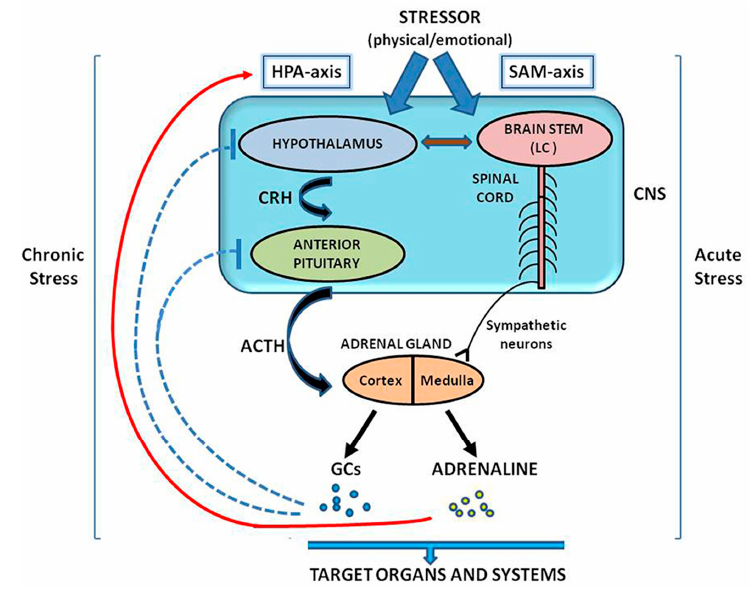
Figure 1. Schematic representation of the actions of HPA and SAM axes in the regulation of stress response. CRH is the key neuroendocrine mediator in HPA activation. The two axes interact with each other, through a positive bidirectional feedback loop, as described above. ACTH, adrenocorticotropic hormone; CNS, central nervous system; CRH, corticotropin releasing hormone; GCs, glucocorticoids; HPA axis, hypothalamic–pituitary–adrenal axis; LC, locus coeruleus; SAM, sympatho–adrenal–medullary axis.